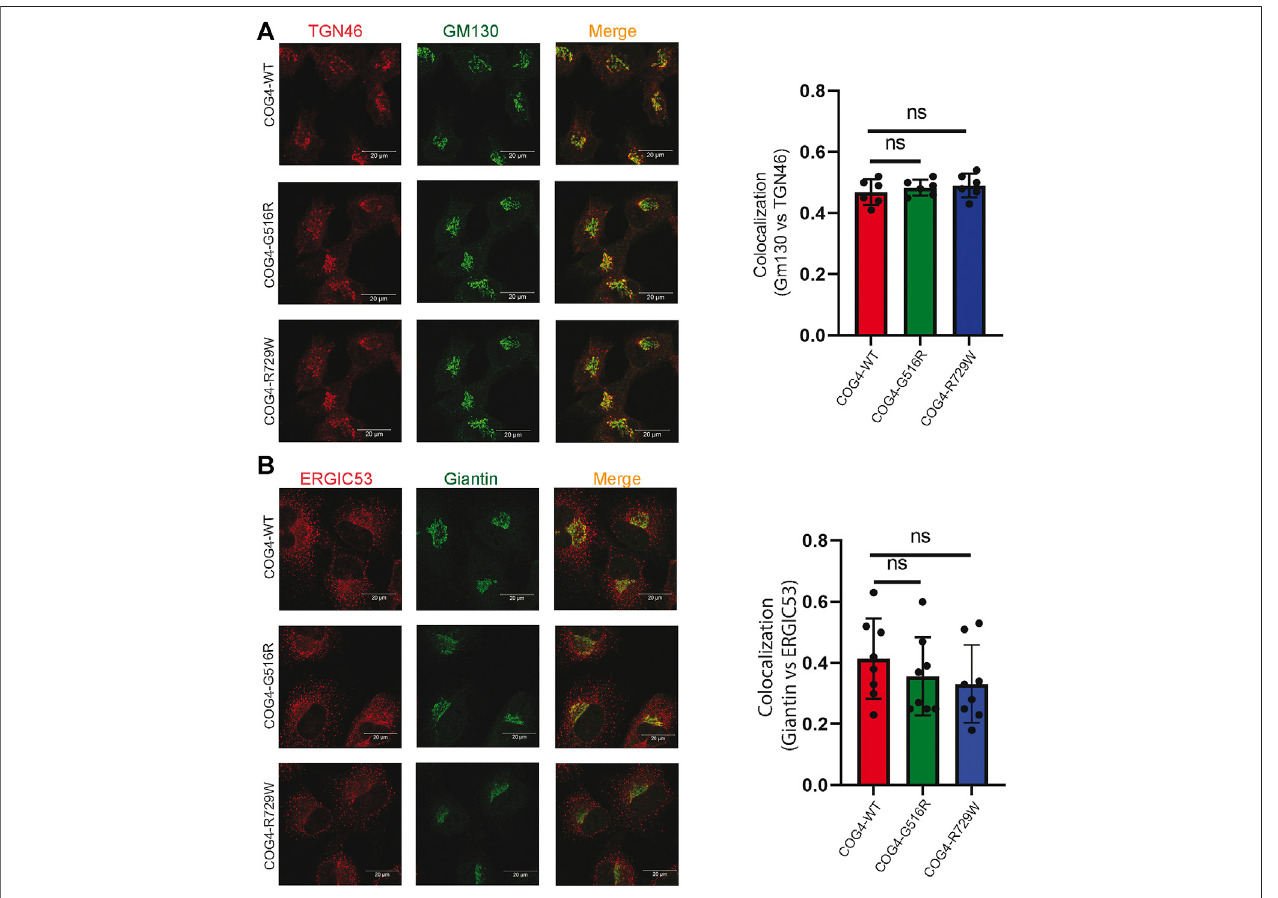
FIGURE 3 | Expression of COG4 mutants does not alter Golgi morphology. (A) Airyscan superresolution IF analysis of RPE1 COG4 wild type, G516R and R729W rescued cells stained for (A) GM130 (green) and TGN46 (red) and (B) GM130 (green) and ERGIC53 (red). Scale bars, 20 µm. Colocalization of TGN46 vs GM130 and ERGIC53 vs GM130 has been performed using Pearson ’ s correlation coef fi cient (Right panel for both (A) and (B) , n (cid:2) 20. Statistical signi fi cance was calculated by GraphPad Prism 8 using one-way ANOVA. p > 0.05, non-signi fi cant (ns). Error bar represents mean ± SD.